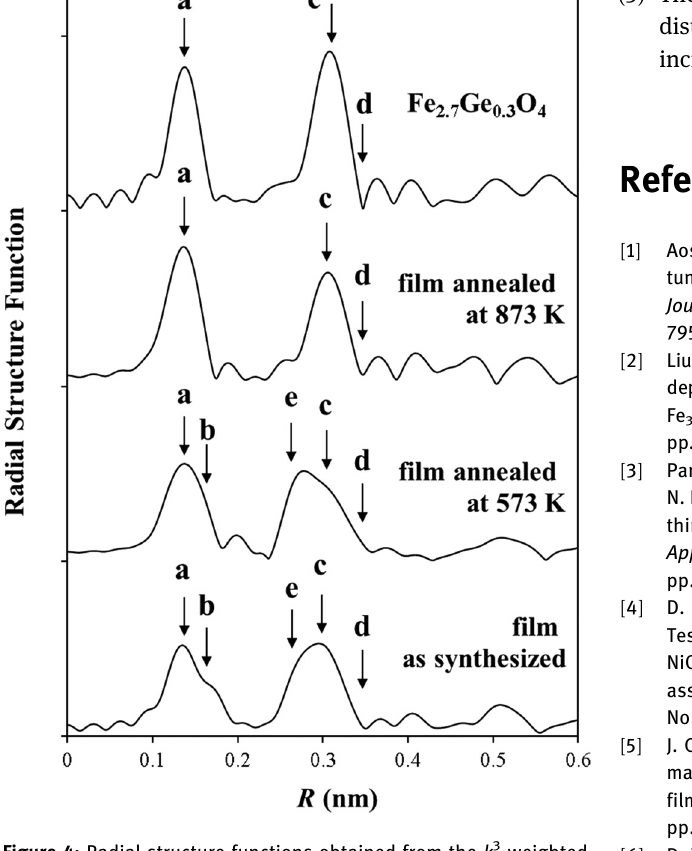
Figure 4: Radial structure functions obtained from the k 3 - weighted EXAFS spectra shown in Figure